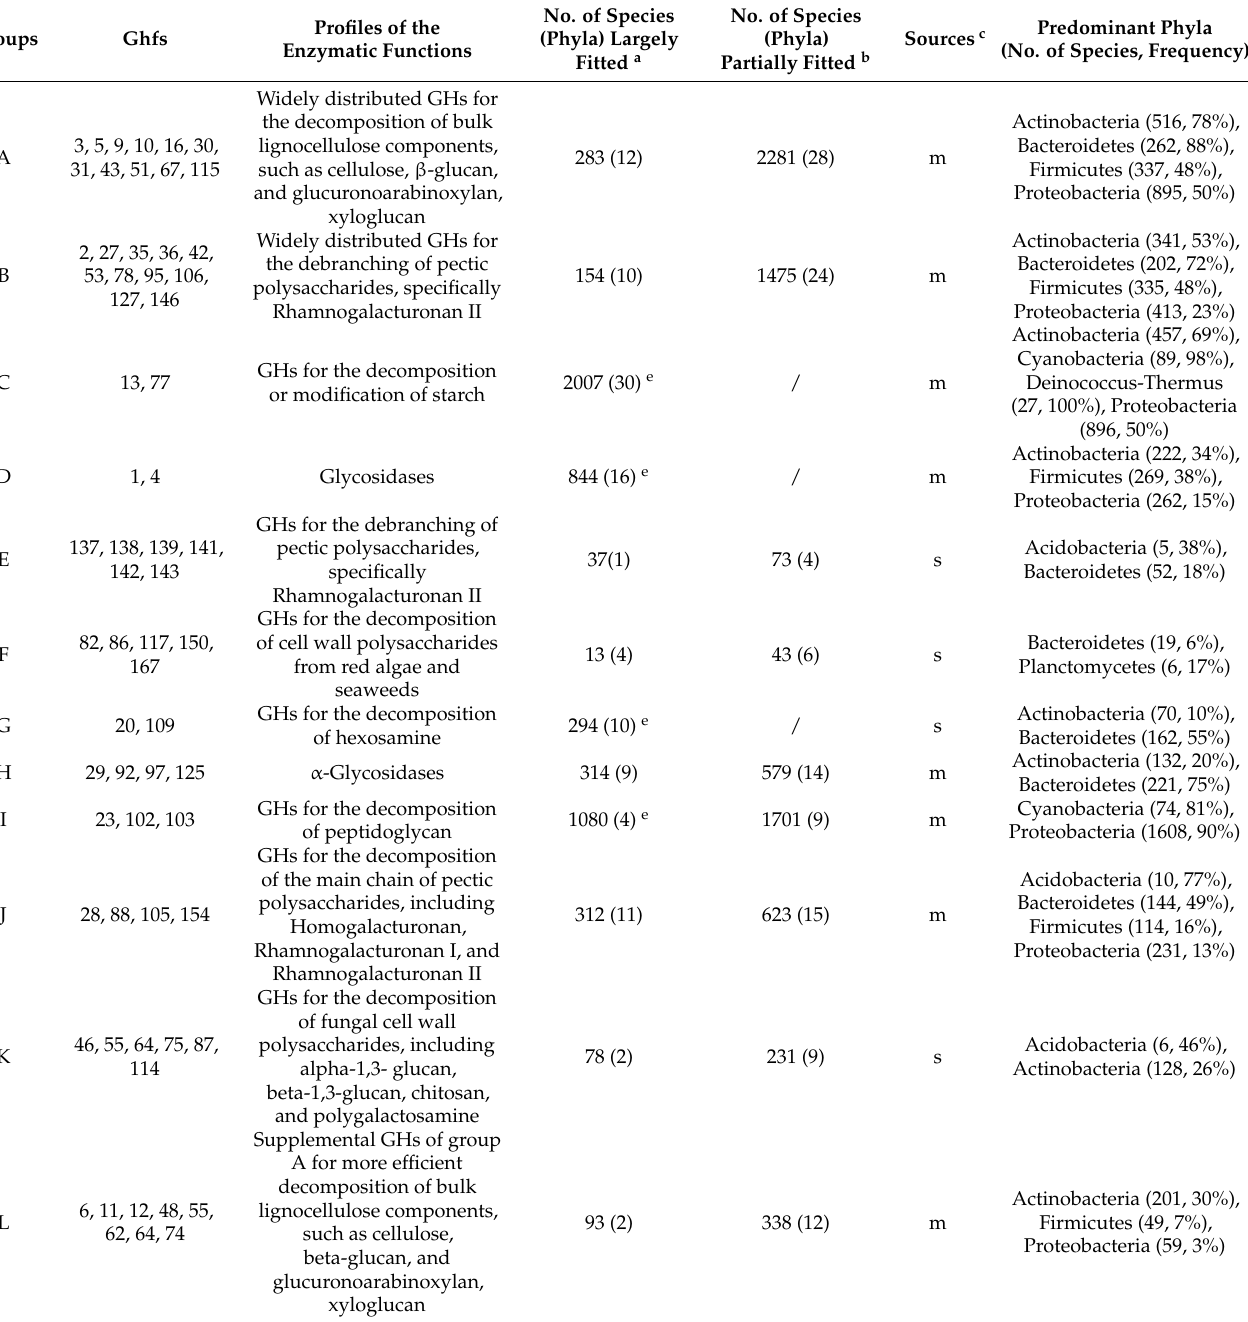
Table 1. GHF distributions and functional